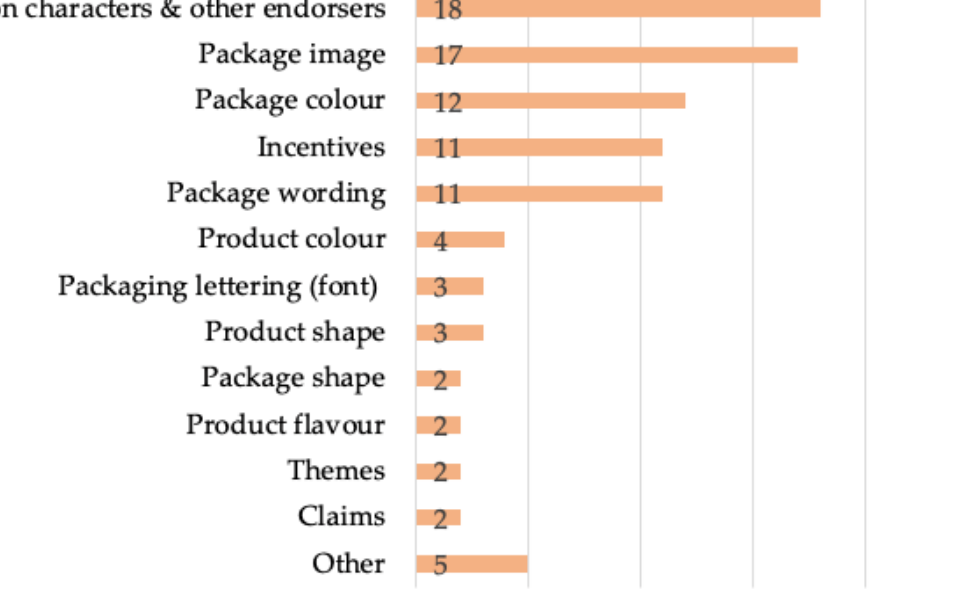
Figure 3. Frequency of child-targeted food packaging indicators examined in studies other than content analyses ( n = 35).